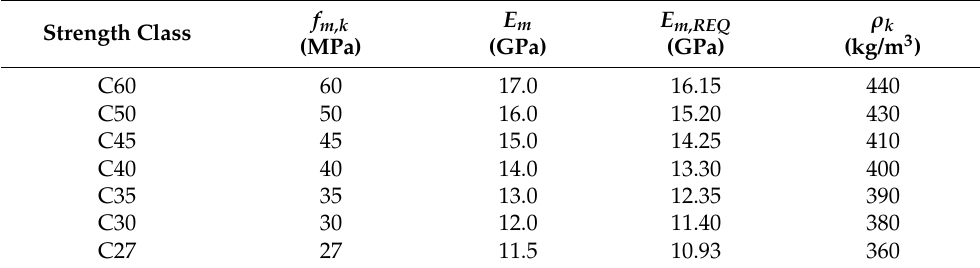
Table 2. Strength classes as described in EN 338 ( f m,k = 5th percentile of bending strength; E m = mean modulus of elasticity; E m,REQ = requirement for the assignment to the class; ρ k = 5th percentile of density). Class C60 is an addition by the